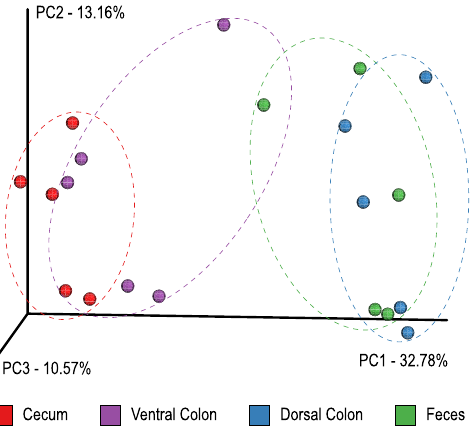
Figure 1. Principal coordinate analysis of gut microbial populations from cecum (red), right ventral colon (green), right dorsal colon (orange) and feces